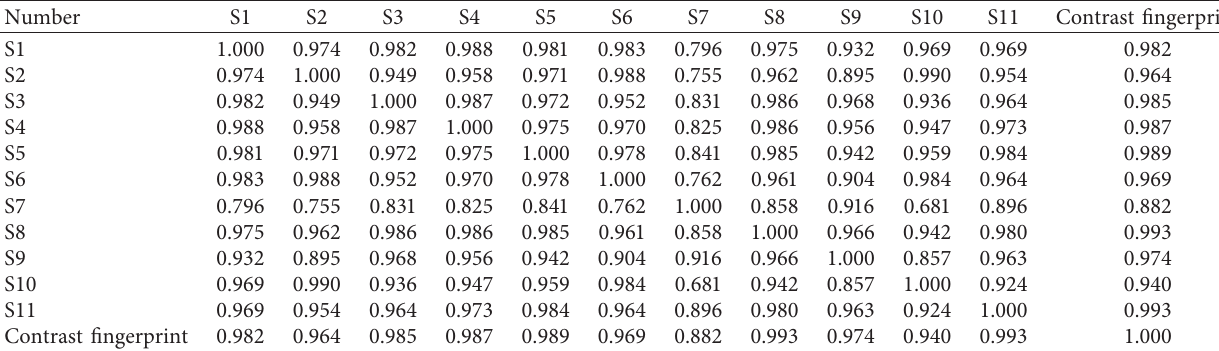
Figure 1: HPLC fingerprints of 11 batches of AMR. (a) Atractylodes III reference substance. (b) Shared mode. (c) Testing sample. Table 4: 11 batches 0f AMR sample similarity